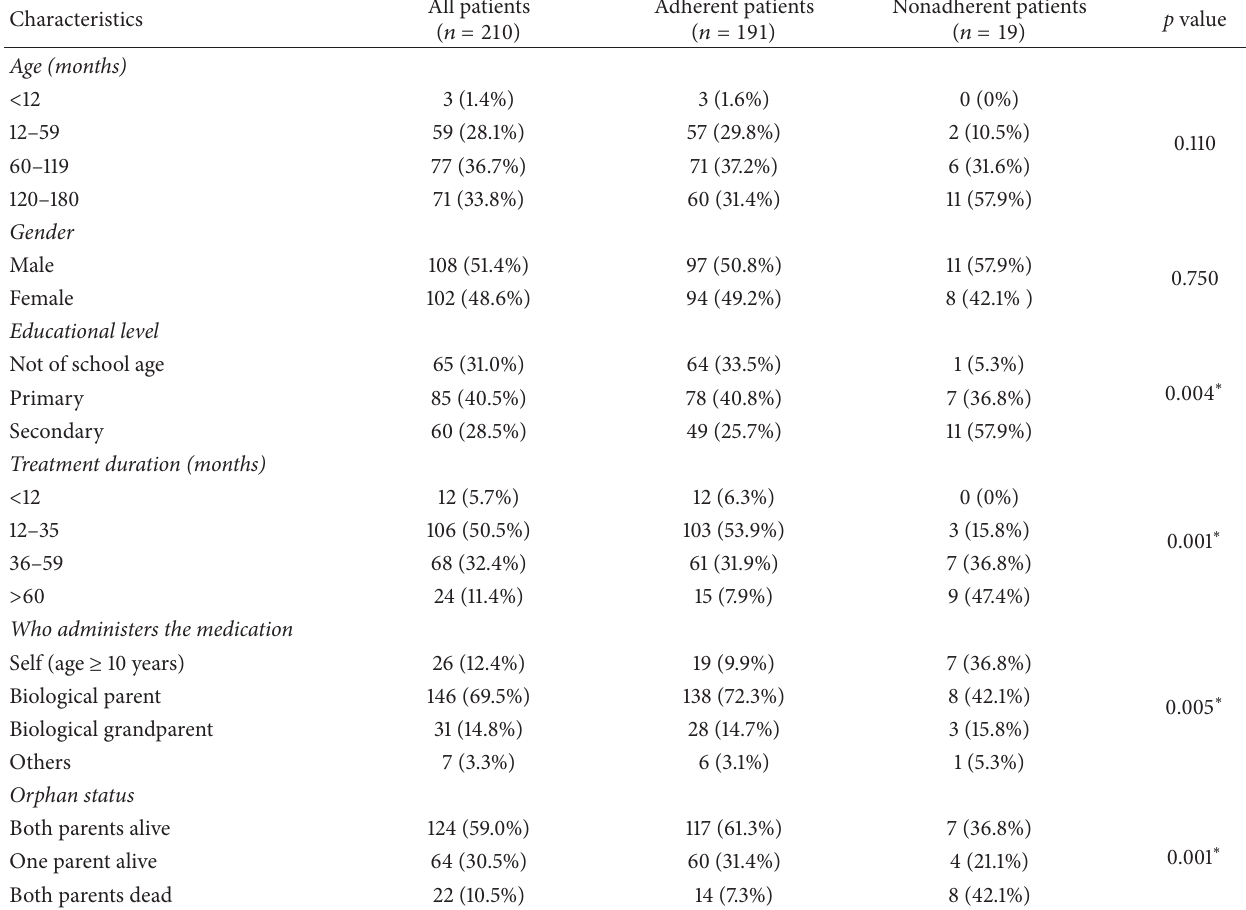
Table 1: Sociodemographic characteristics of the children studied ( 𝑛 = 210 ).